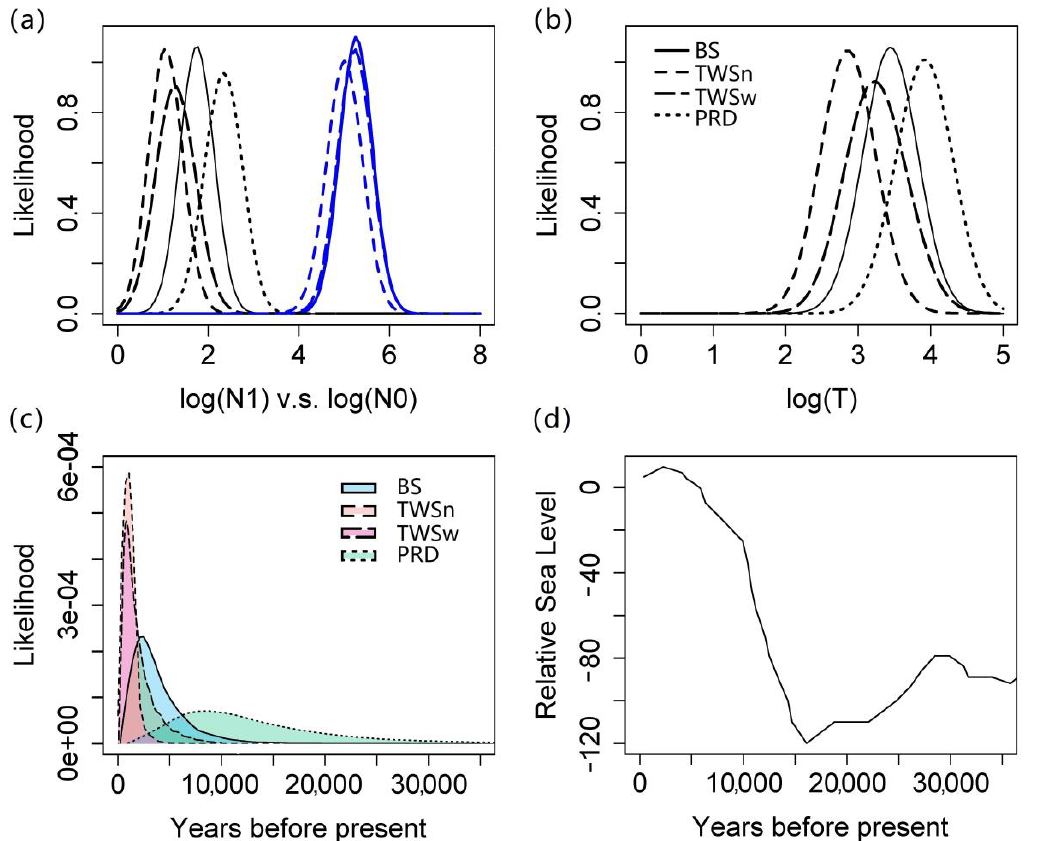
Figure 2. Inference of demographic reduction in four finless porpoise populations in China’s coastal waters (BSn: the narrow-ridged finless porpoise population from Bohai Sea; TWSn and TWSw: the narrow-ridged and wide-ridged finless porpoise population from Taiwan Strait; and PRDw: the wide-ridged finless porpoise population from the Pearl River Delta region) using MSVAR1.3. Posterior distribution for the ( a ) contemporary effective population size ( N 0 , black lines) and ancestral size before the demographic change ( N 1 , blue lines); ( b ) time since the detected demographic event; ( c ) time of demographic events plotted in linear scale for comparison with ( d ) sea level fluctuation since the late Pleistocene.